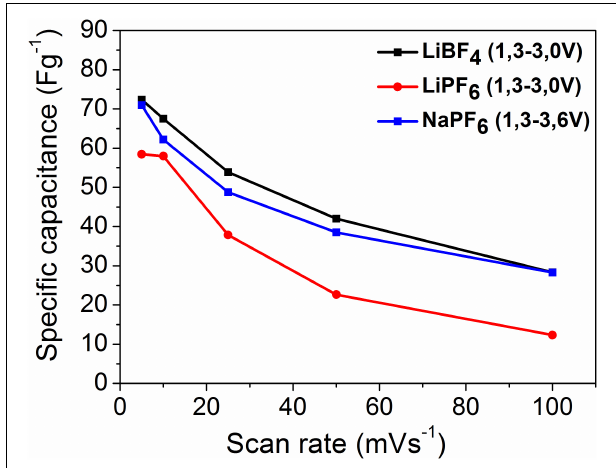
FIGURE 2 | Specific capacitance (C sp , CV) vs. scan rate in different organic electrolytes and potential windows, with scan rates 1, 10, 25, 50, and 100 mVs − 1